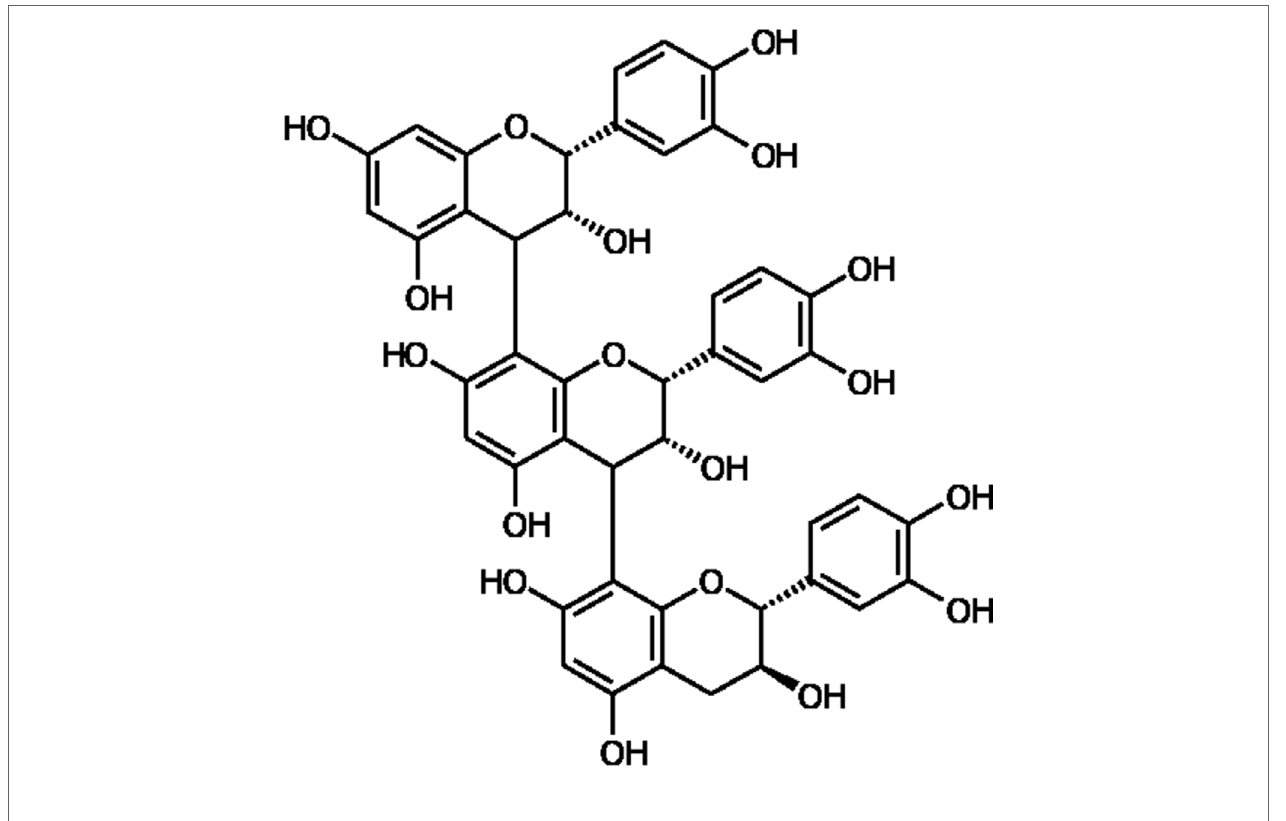
FIGURE 1 | Structural representation of a procyanidin molecule consisting of catechin and epicatechin subunits which are the main constituents of Pycnogenol (PYC). The catechin and epicatechin units can be linked by different bonds, the main being C4-C8 bonds and C4-C6 bonds as well as C4-C8 bonds with different chain lengths up to